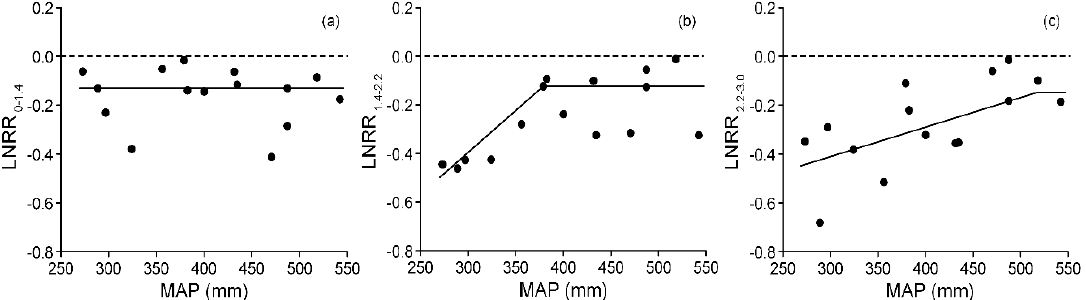
Figure 4. Changes in LNRR with the mean annual precipitation (MAP) gradient. ( a ) LNRR at 0–1.4 m; ( b ) LNRR at 1.4–2.2 m; ( c ) LNRR at 2.2–3.0 m.